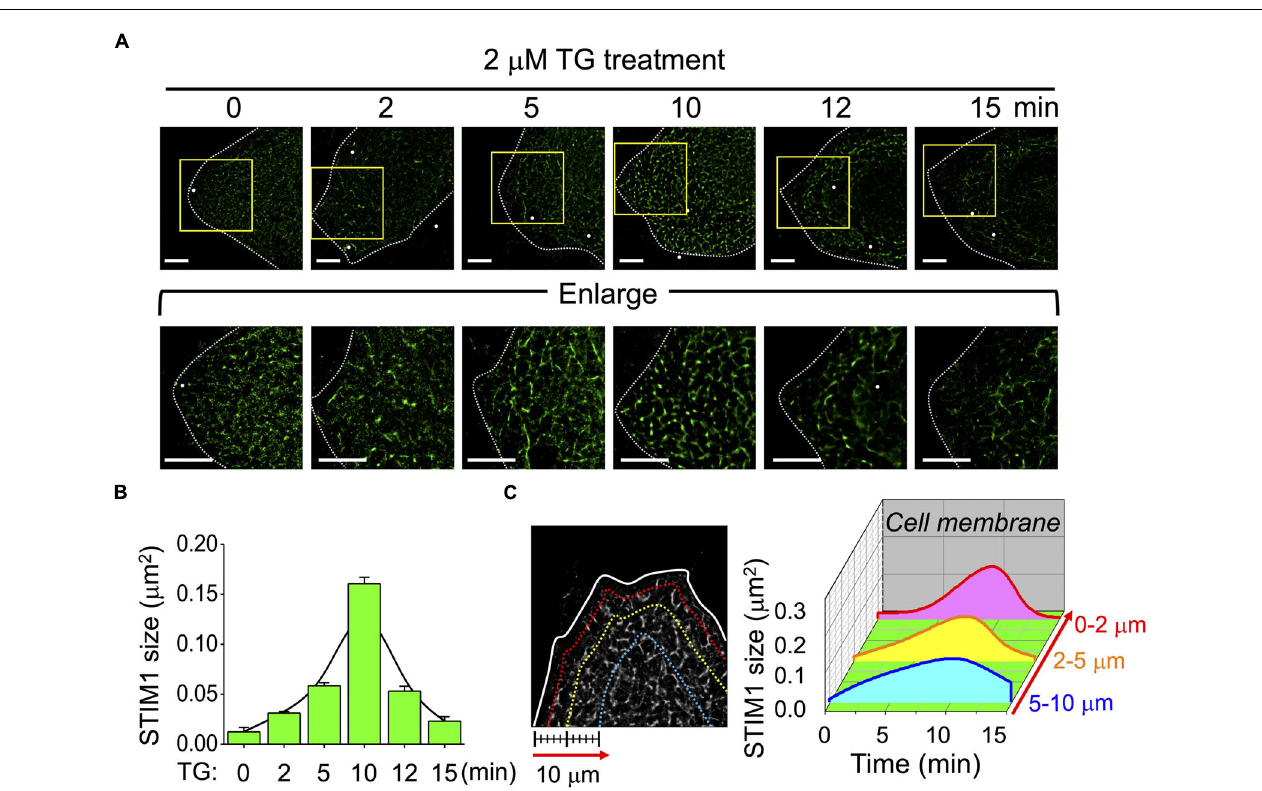
FIGURE 2 | Spatiotemporal distribution of STIM1 during store-operated Ca 2 + entry (SOCE) activation. (A) Representative dSTORM images of fixed cells at different time points of SOCE illustrating the intracellular distributions of STIM1 of SiHa cells upon TG treatment. Lower panels showing the enlargement of the areas indicated by rectangles in whole-cell images. Dashed line, cell periphery. White dots, TetraSpeck microspheres. Scale bar, 5 µ m. (B) Quantitative analyses of STIM1 sizes at each indicated time point in TG-induced SOCE. Fitting curve, fitting a Gaussian curve to a bar graph. Each value represents mean ± SEM from at least six individual cells of three independent experiments. (C) (Left) The distribution of STIM1 proteins at 2, 5, and 10 µ m from the cell periphery. (Right) Quantitative analyses of STIM1 proteins based on their intracellular areas and sizes. The X -axis indicated the time point after TG treatment. The Y -axis indicated the distribution of STIM1 proteins according to the distance from cell membrane. The Z -axis illustrated the average STIM1 sizes located in the indicated region at each time point. Data from more than six different cells of three independent experiments.